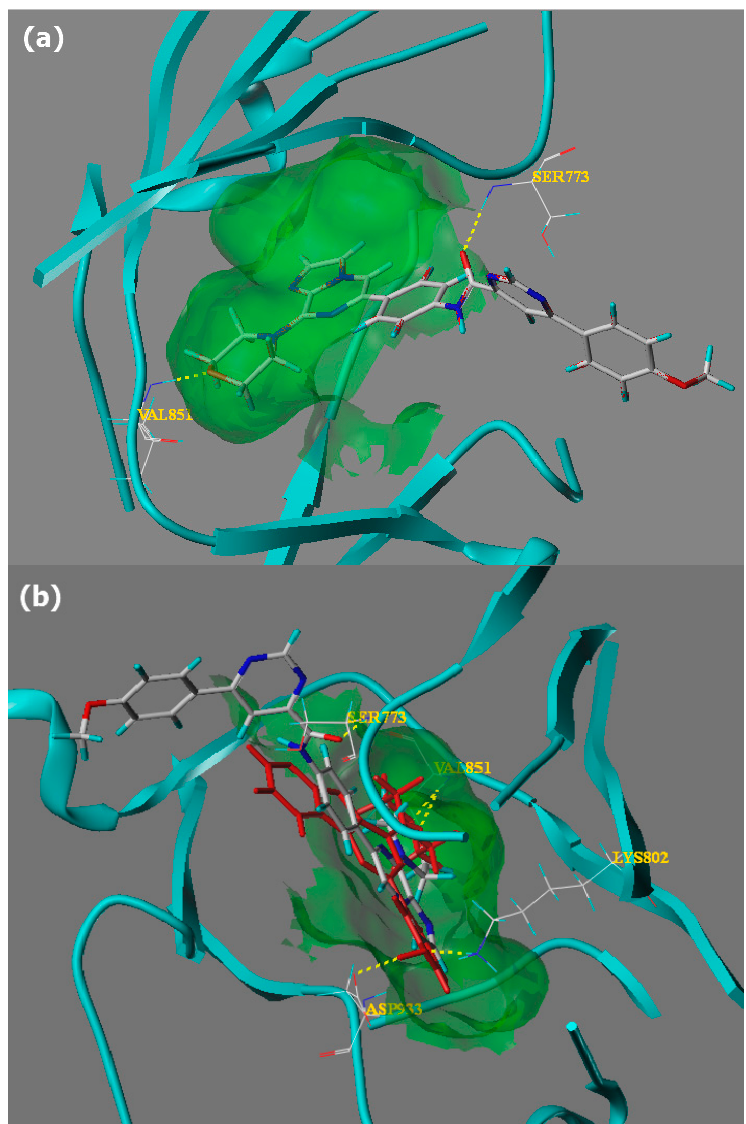
Figure 2. Binding models: The proteins were displayed by cyan ribbon. Hydrogen bonds were showed in dashed lines (yellow). ( a ) Binding models of compound 14c (shown in Capped Sticks) with PI3K α ; ( b ) Binding models of compound 14c and native ligand PI 103 (shown in red Sticks) with PI3K α .